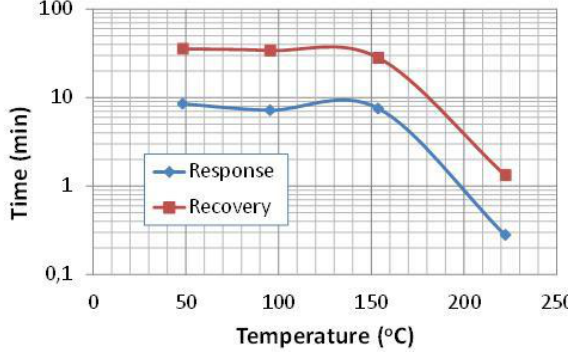
Figure 9. Variation of response and recovery times vs. temperature for sample S3.